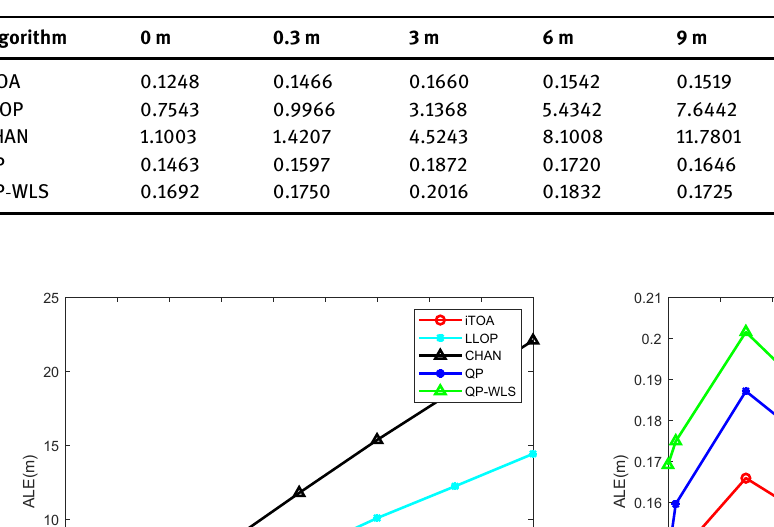
Table 2: ALE of each algorithm under di ff erent time synchronization error values